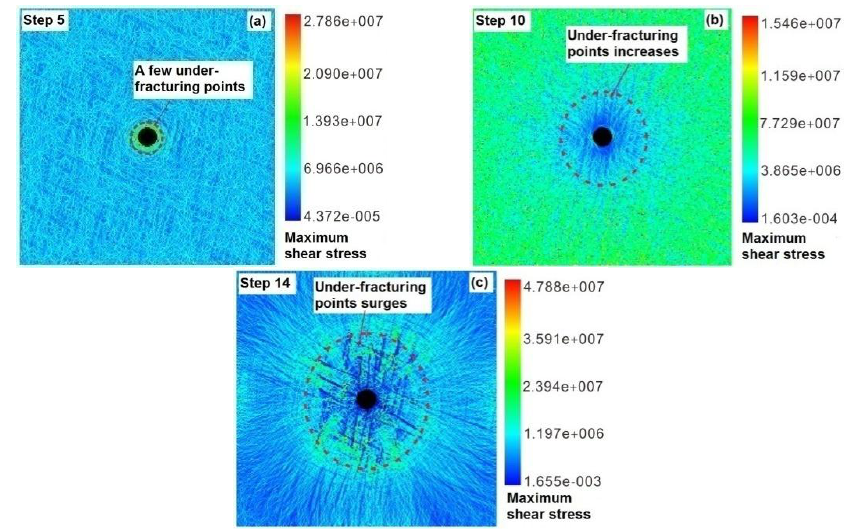
Figure 9. The selection occasions of variable injection-rate technology for Case 4: ( a ) at step of 5, a few under fracturing points appear; ( b ) at step of 10, under-fracturing points increases gradually; and ( c ) at step of 14, the under-fracturing points surges).